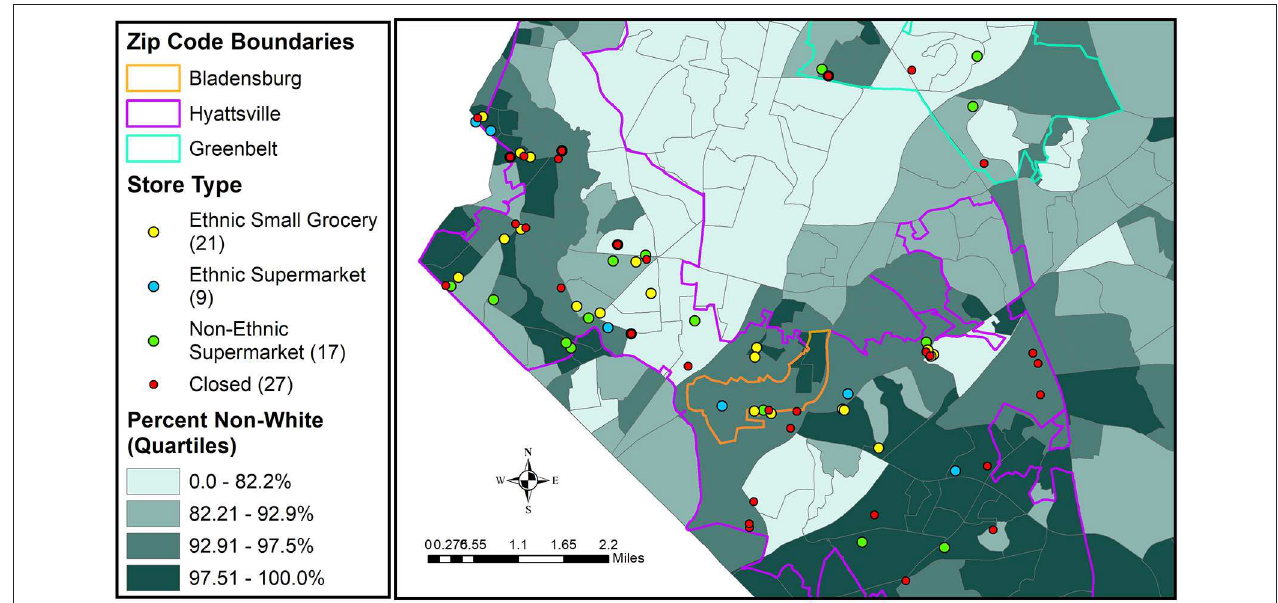
FIGURE 5 | Distribution of closed and ethnic stores across Bladensburg, Greenbelt, and Hyattsville, MD (2018).